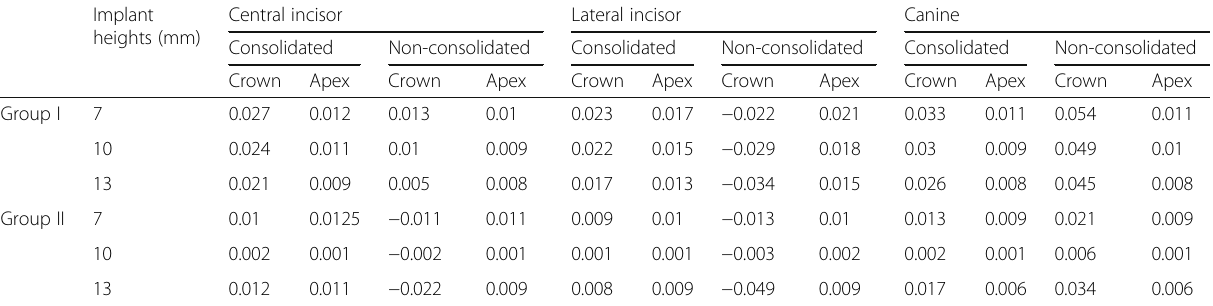
Table 3 Anterio-posterior displacements in consolidated and non-consolidated model in group I and group II models (mm) Implant heights